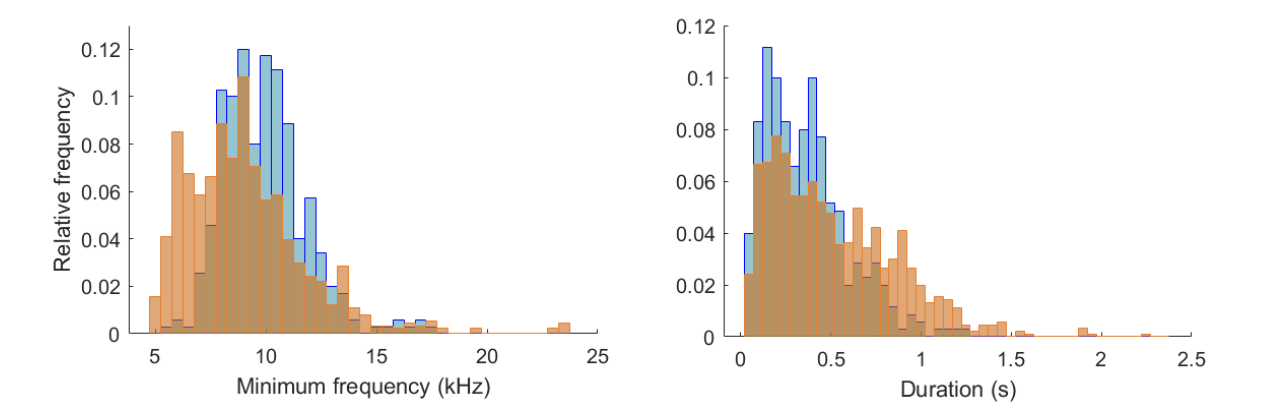
Figure 11. Histograms of the minimum frequency and duration of the whistles before (blue) and after (brown) detonation.